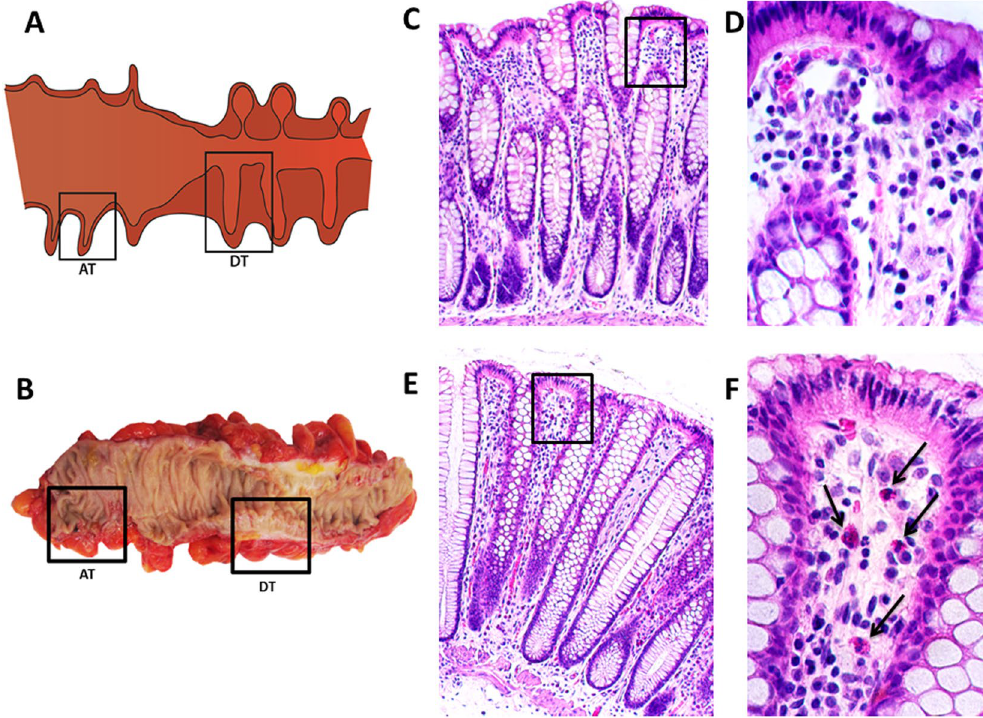
Figure 1. Evaluation of chronically diseased tissue and adjacent tissue obtained from the sigmoid colon of chronic, recurrent diverticulitis patients. (A ) Illustrated representation of the sigmoid colon with areas obtained for analysis shown in boxes. Chronically diseased tissue (DT) is an area of thickened bowel wall. Adjacent tissue (AT) is an area of normal bowel wall thickness. Diverticulae may be present in either tissue section. (B ) Sigmoid colon taken from a patient immediately after resection and representative tissue sections shown in boxes. (C ) Representative H&E stained section from AT shows minimal mucosal neutrophilic inflammation. (D ) Higher magnification of the boxed area of (C) showing negligible mucosal inflammation. (E ) Representative H&E stained section from DT with minimal mucosal inflammation demonstrated by the presence of few mucosal neutrophils within the lamina propria. (F ) Higher magnification of the boxed area of (E ) with neutrophils marked by an